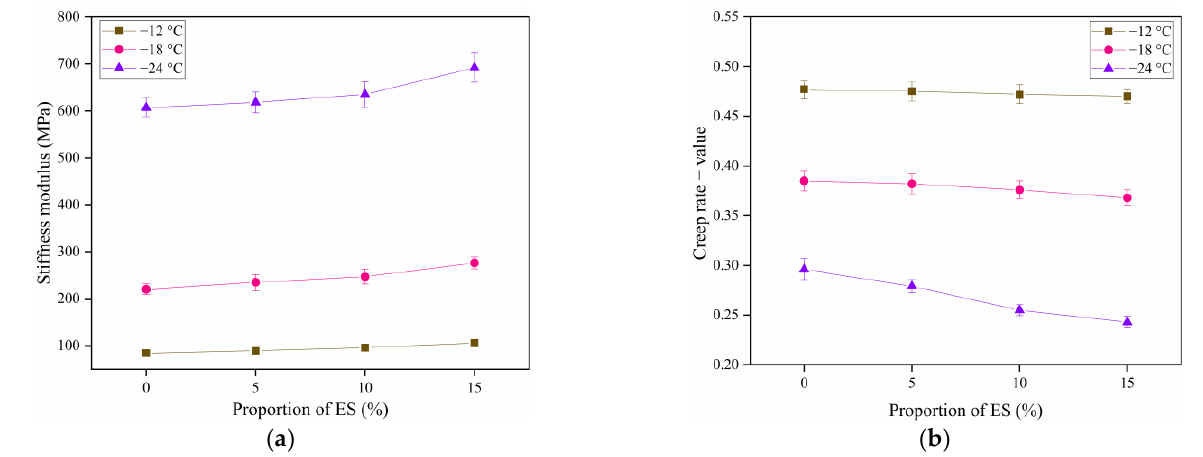
Figure 10. Stiffness modulus and creep rate of bitumen materials with different eggshell powder contents: ( a ) stiffness modulus (s); ( b ) creep rate (m − value).